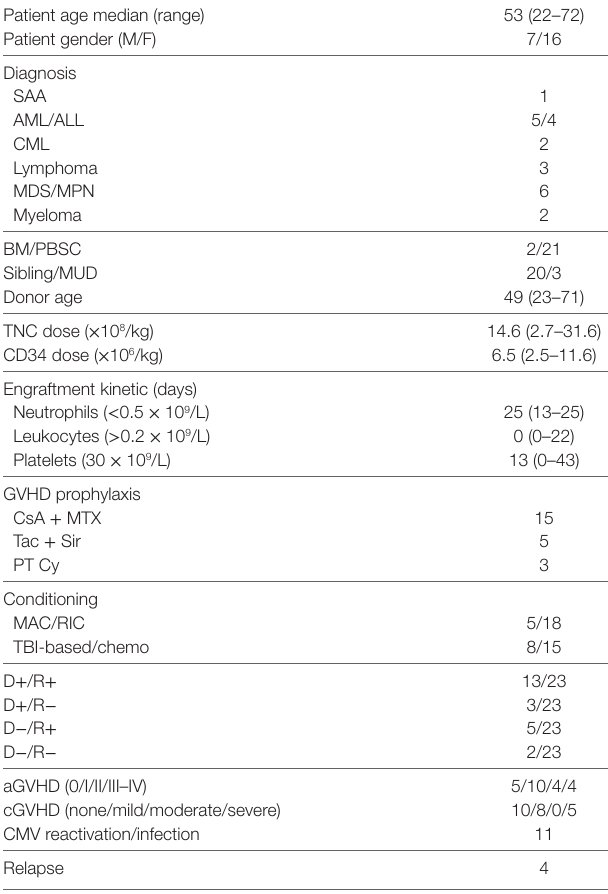
Table 1 | Patients characteristics and hematopoietic stem cell transplantation